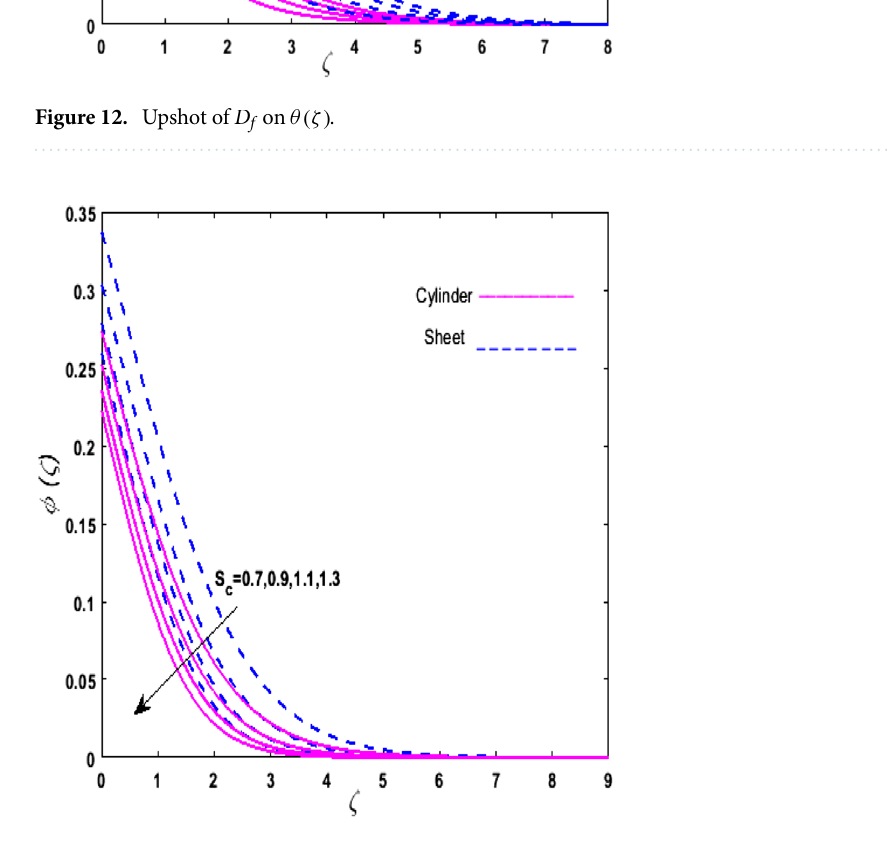
Figure 13. Upshot of S c on φ(ζ)